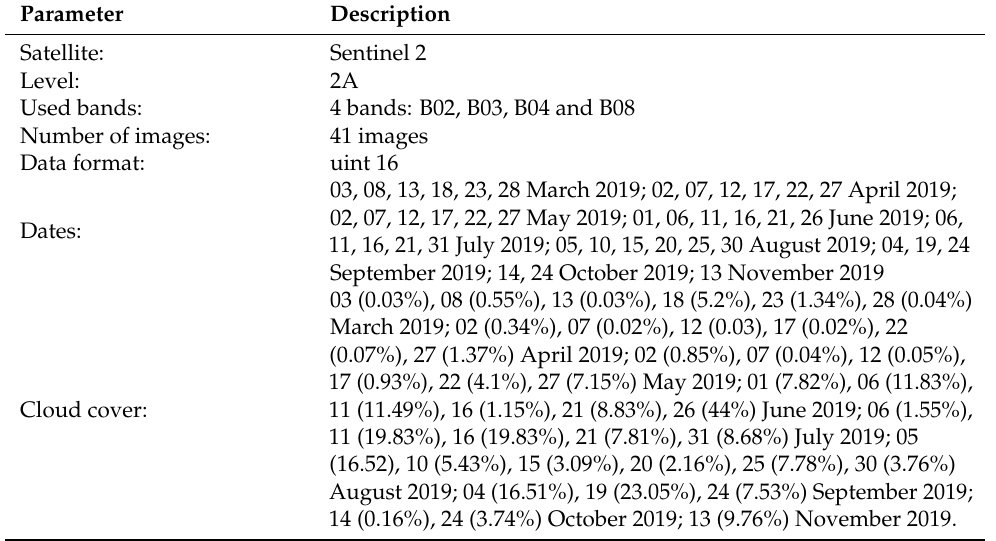
Table 1. Characteristics of the Sentinel 2 satellite